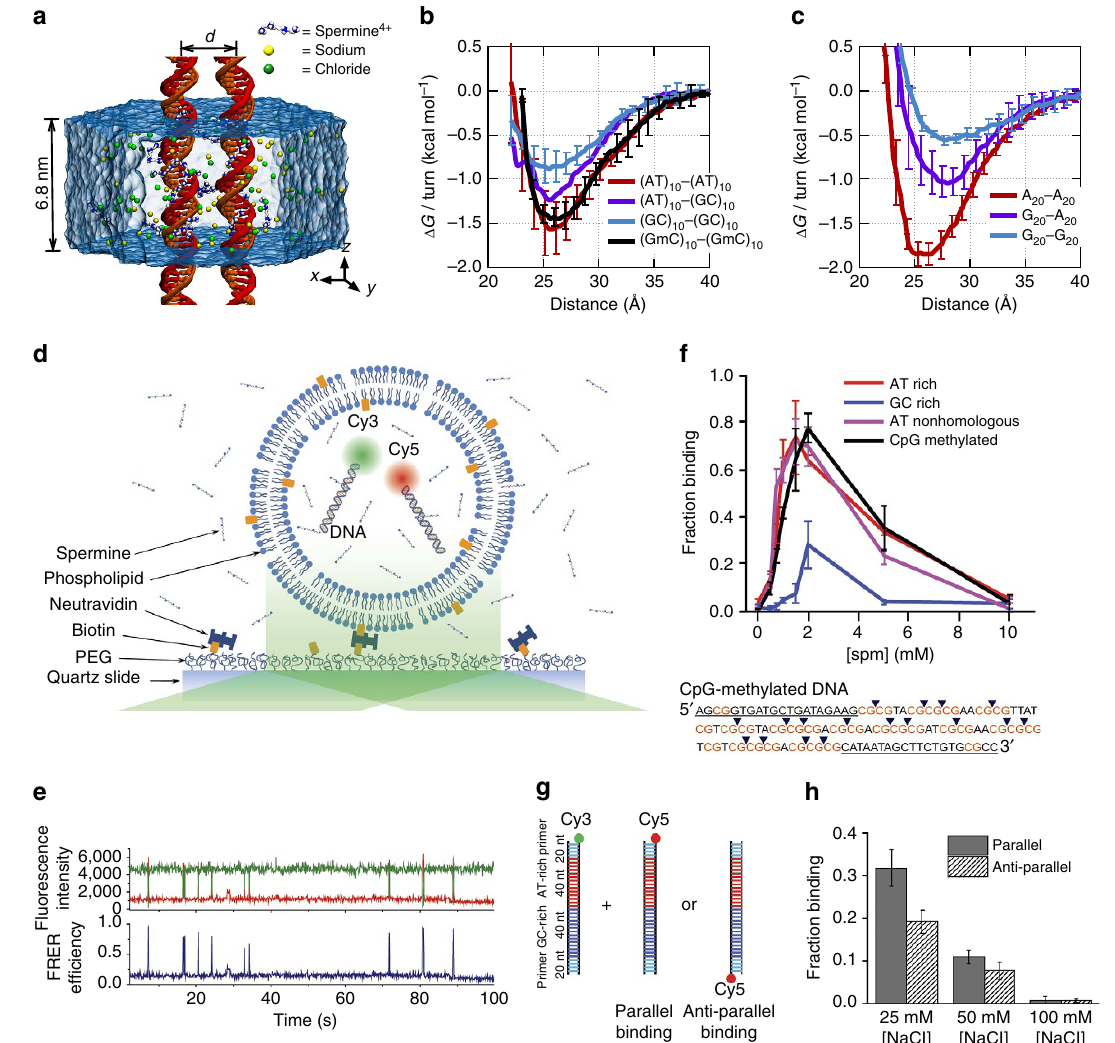
Figure 1 | Polyamine-mediated DNA sequence recognition observed in MD simulations and smFRETexperiments. ( a ) Set-up of MD simulations. A pair of parallel 20-bp dsDNA duplexes is surrounded by aqueous solution (semi-transparent surface) containing 20 Sm 4 þ molecules (which compensates exactly the charge of DNA) and 100mM NaCl. Under periodic boundary conditions, the DNA molecules are effectively infinite. A harmonic potential (not shown) is applied to maintain the prescribed distance between the dsDNA molecules. ( b , c ) Interaction free energy of the two DNA helices as a function of the DNA–DNA distance for repeat-sequence DNA fragments ( b ) and DNA homopolymers ( c ). ( d ) Schematic of experimental design. A pair of 120-bp dsDNA labelled with a Cy3/Cy5 FRETpair was encapsulated in a B 200-nm diameter lipid vesicle; the vesicles were immobilized on a quartz slide through biotin–neutravidin binding. Sm 4 þ molecules added after immobilization penetrated into the porous vesicles. The fluorescence signals were measured using a total internal reflection microscope. ( e ) Typical fluorescence signals indicative of DNA–DNA binding. Brief jumps in the FRET signal indicate binding events. ( f ) The fraction of traces exhibiting binding events at different Sm 4 þ concentrations for AT-rich, GC-rich, ATnonhomologous and CpG-methylated DNA pairs. The sequence of the CpG-methylated DNA specifies the methylation sites (CG sequence, orange), restriction sites (BstUI, triangle) and primer region (underlined). The degree of attractive interaction for the ATnonhomologous and CpG-methylated DNA pairs was similar to that of the AT-rich pair. All measurements were done at [NaCl] ¼ 50mM and T ¼ 25 (cid:2) C. ( g ) Design of the hybrid DNA constructs: 40-bp AT-rich and 40-bp GC-rich regions were flanked by 20-bp common primers. The two labelling configurations permit distinguishing parallel from anti-parallel orientation of the DNA. ( h ) The fraction of traces exhibiting binding events as a function of NaCl concentration at fixed concentration of Sm 4 þ (1mM). The fraction is significantly higher for parallel orientation of the DNA